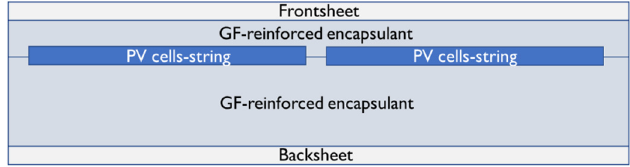
Fig. 2. Schematic buildup of a lightweight module with